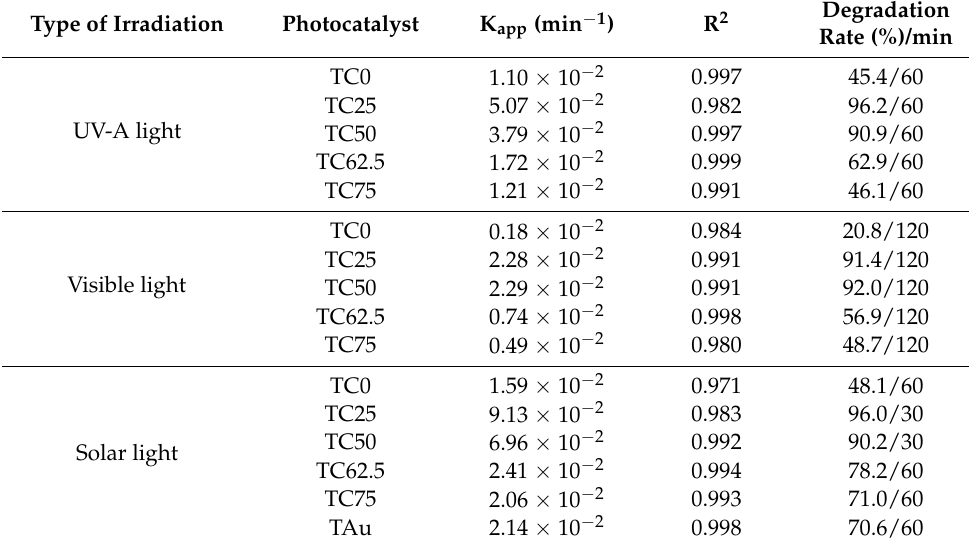
Table 1. Comparison of photocatalytic efficiency between TC0–75 and TAu using the first order fitting kinetic data of MO degradation under different radiation